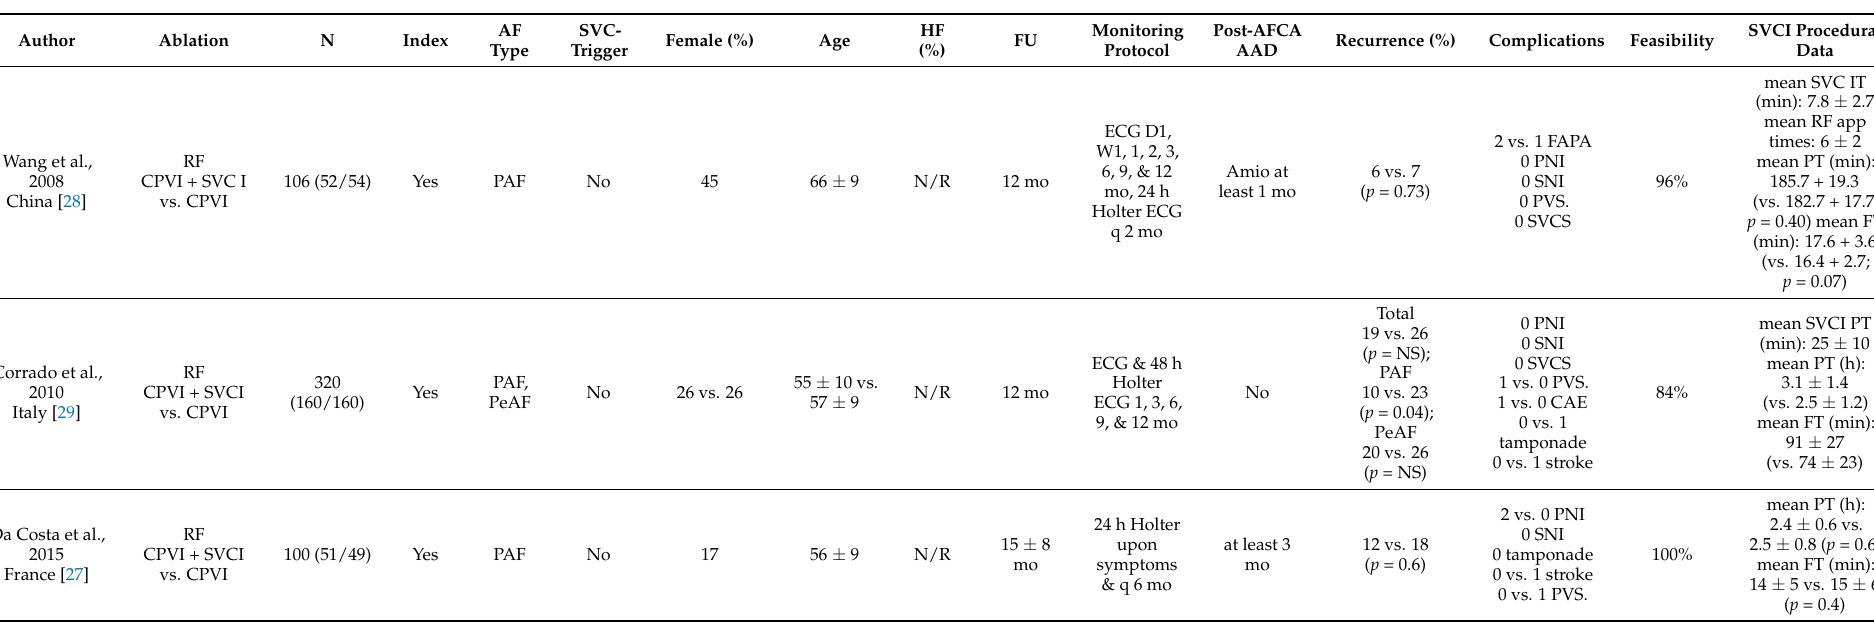
Table 1. Randomized controlled trials comparing pulmonary vein isolation versus pulmonary vein isolation plus superior vena cava isolation in patients with atrial